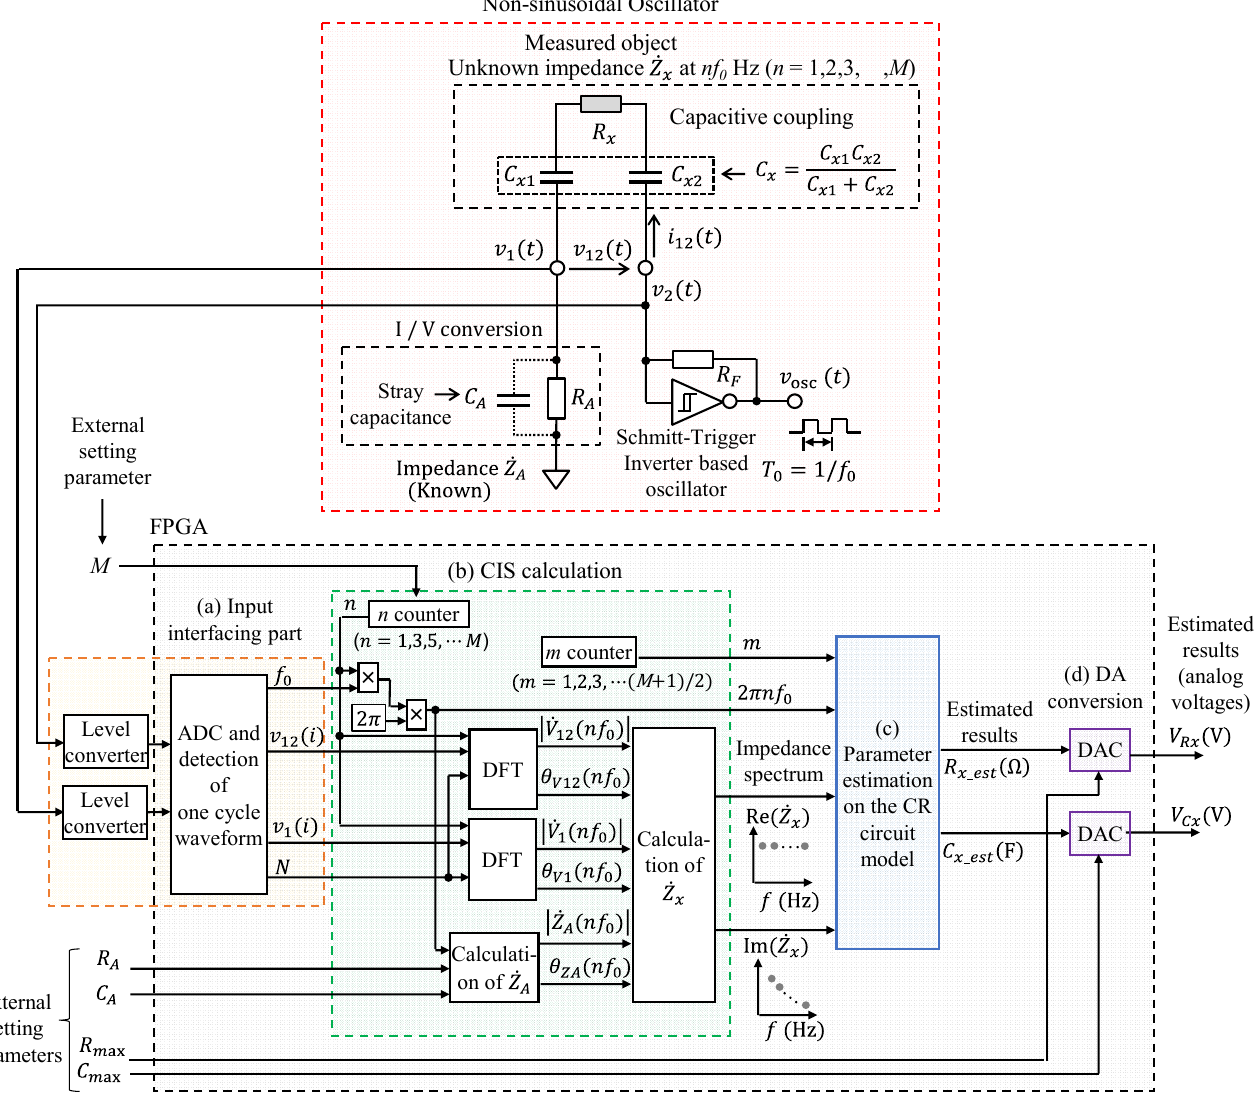
Figure 1. Block diagram of the constructed system composed of a nonsinusoidal oscillator involving the measured object R x in series with unknown capacitance C x , a FPGA-based processor for CIS, and the parameter estimation on the CR circuit model.